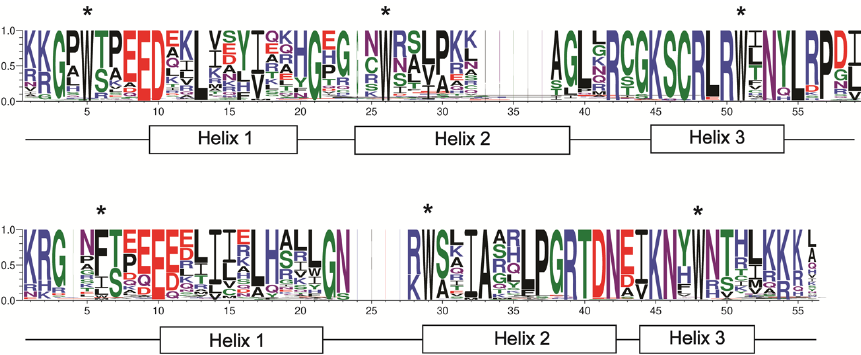
Figure 2. Conservation domain structure analysis of MaMYB proteins. Sequence logos of the R2 ( a ) and R3 ( b ) MYB repeats for the full-length alignment of all R2R3-MYB domains from the Musa acuminata genome. The bit score indicates the information content for each position in the sequence. The positions of the three α -helices are marked (Helix 1 to 3). The asterisks (*) indicate the conserved tryptophan residues (W) in the MYB domain.